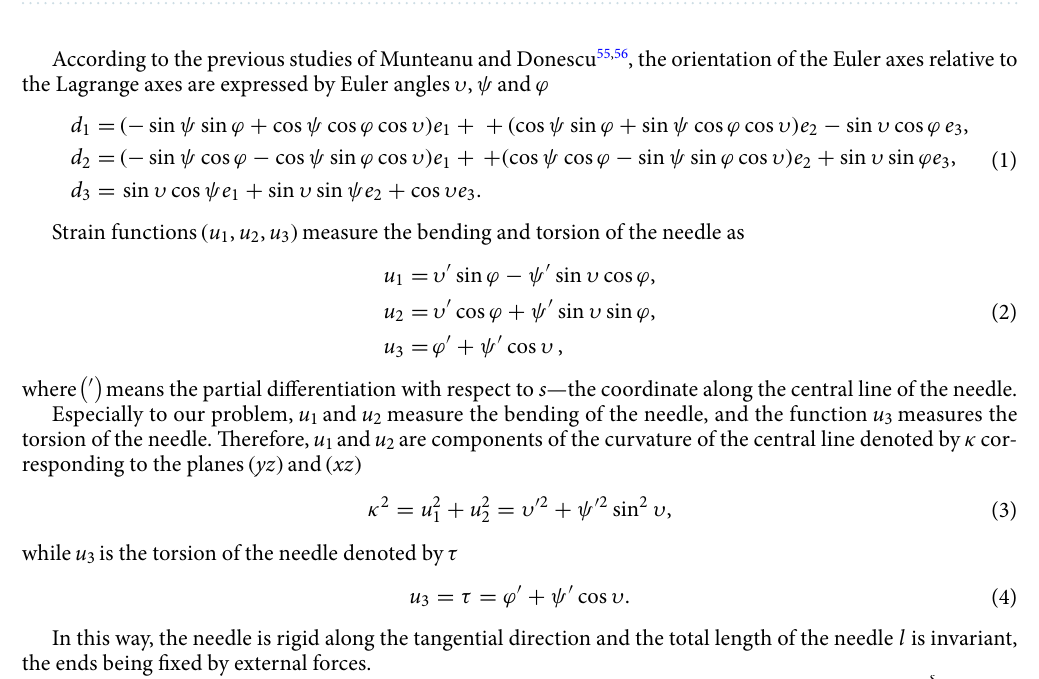
Figure 3. Schematic of the needle with the Lagrange coordinate system OXYZ and the Euler coordinate system oxyz